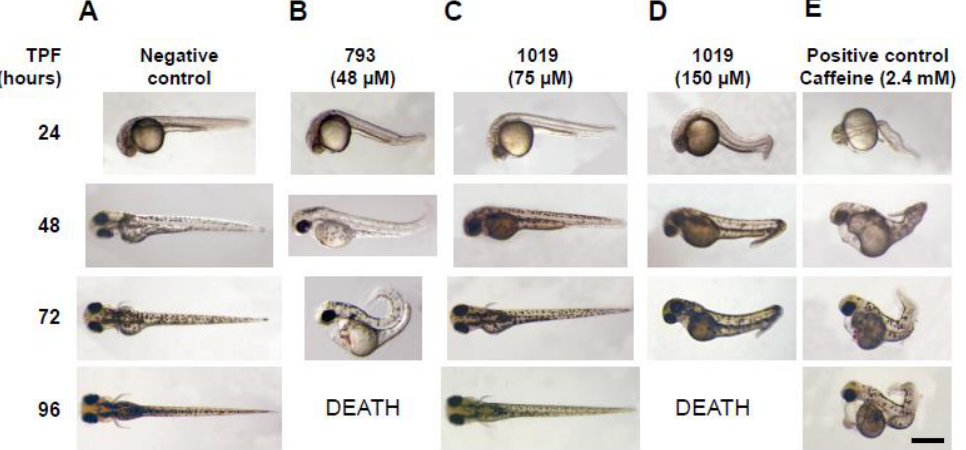
Figure 1. Fish Embryo Toxicity Test. Examples of zebrafish embryos treated with different com- pounds, or vehicle alone, from 6 to 96 h post-fertilization (hpf), are shown at key time points. ( A ) Embryos exposed to 1% v / v of dimethylsulfoxide (DMSO). ( B ) Embryos treated with compound 793 at 48 µ M. ( C ) Compound 1019 at 75 µ M. ( D ) Compound 1019 at 150 µ M. ( E ) Embryos exposed to 2.4 mM caffeine (positive teratogenic agent). Scale bar: 0.5 mm. TPF: time